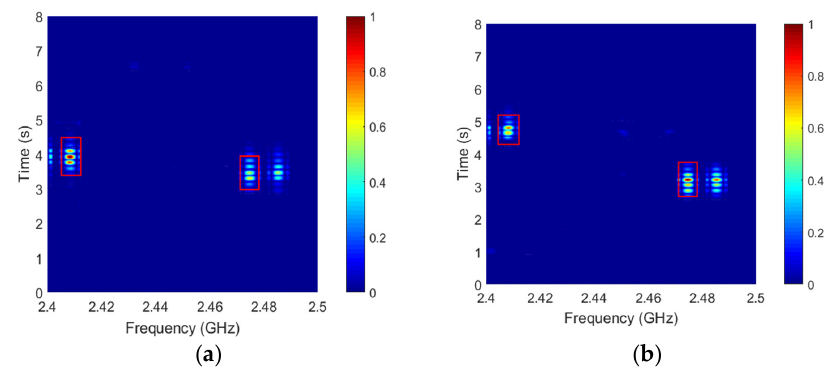
Figure 26. The HOC method results for two UAVs indoors at distances of ( a ) 5 m and ( b ) 10 m.